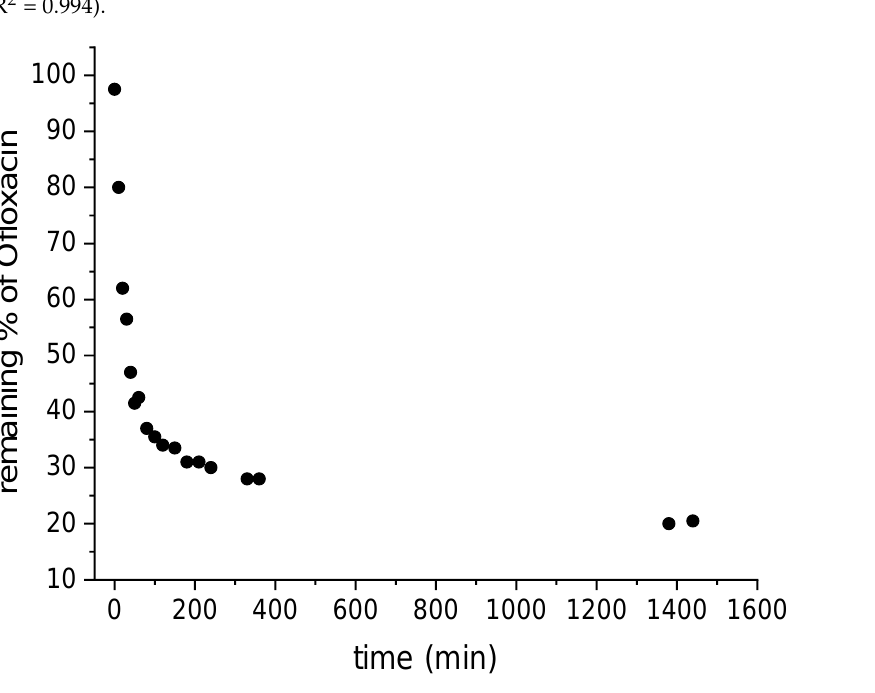
Figure 14. Adsorption kinetic study for OFL-contaminated UWW performed in the presence of the PMMA x - co -PDEAEMA y /PVP/Fe x O y crosslinked fibrous membranes at pH PMMA x - co -PDEAEMA y /PVP/Fe x O y crosslinked fibrous membranes at pH 4.